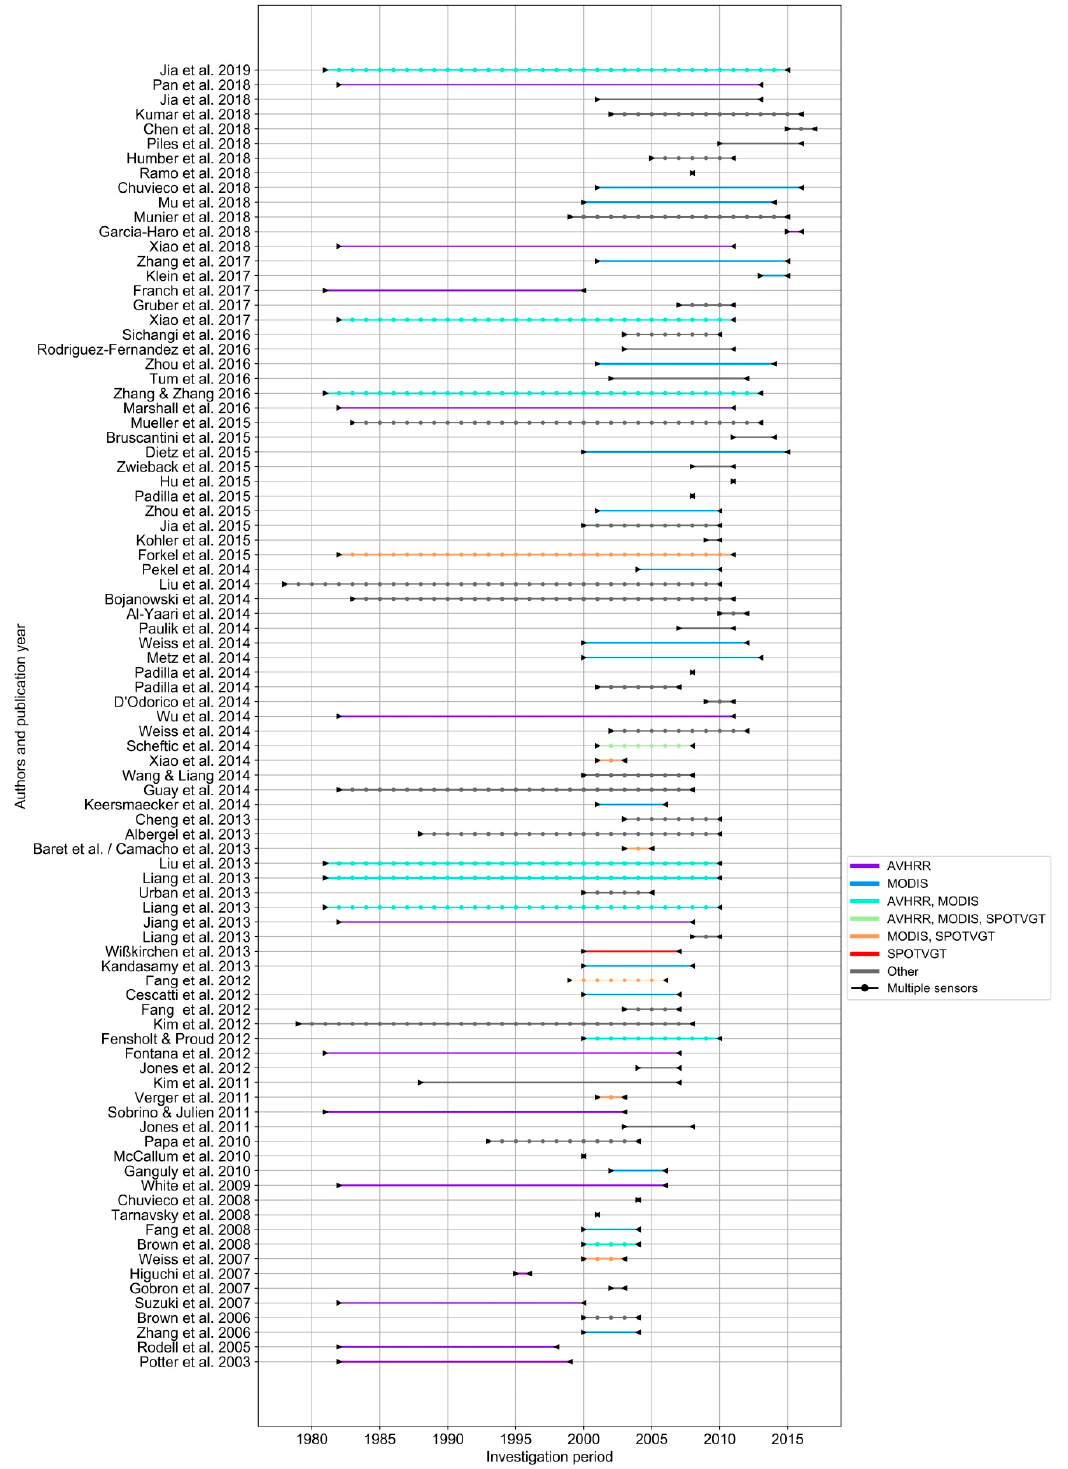
Figure 7. Investigation periods and data sources of the reviewed studies. The coloring highlights the three most frequently utilized sensors as well as their combinations.